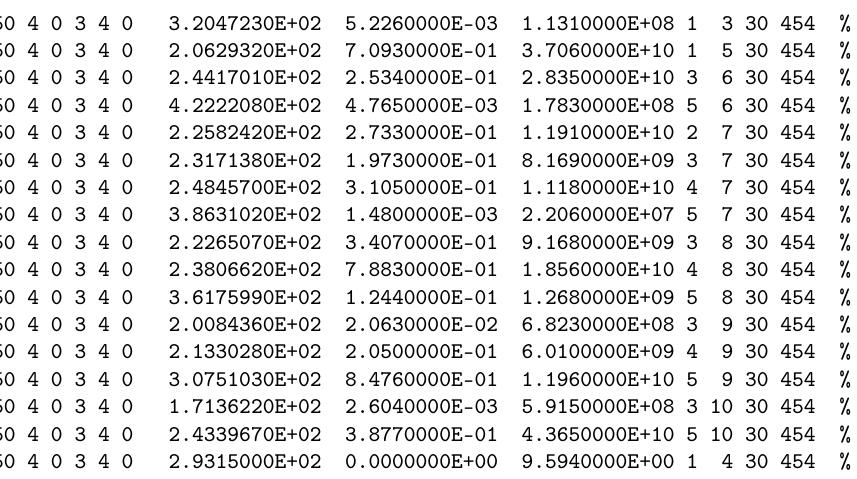
Figure 3. Excerpt of file d 454 t 050 of the XSTAR database listing the radiative transitions with upper level k ≤ 10 (data type dt = 50 and rate type rt = 4) in Mg-like Zn XIX ( ion = 454). Data type dt = 86, listing the radiative and Auger widths of K-vacancy levels, is also an interesting case as it involves transitions between different ion-charge states (Figure